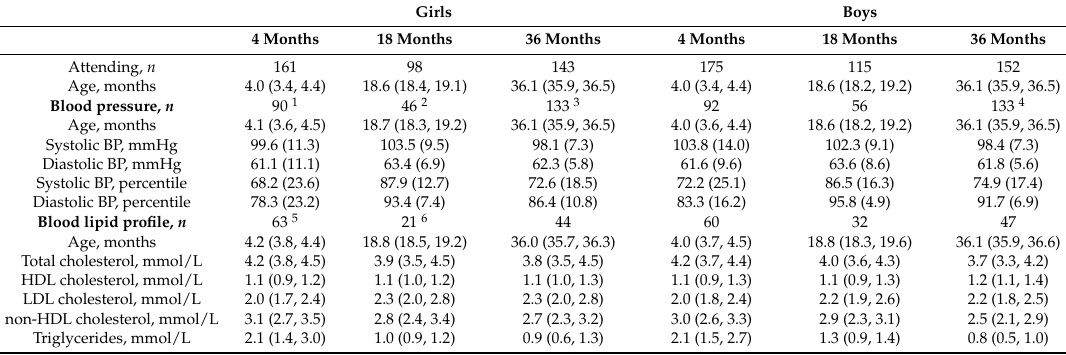
Table 3. Blood pressure and blood lipid profile at the three different time points, stratified by sex. Values are presented as mean (SD) if normally distributed, otherwise median